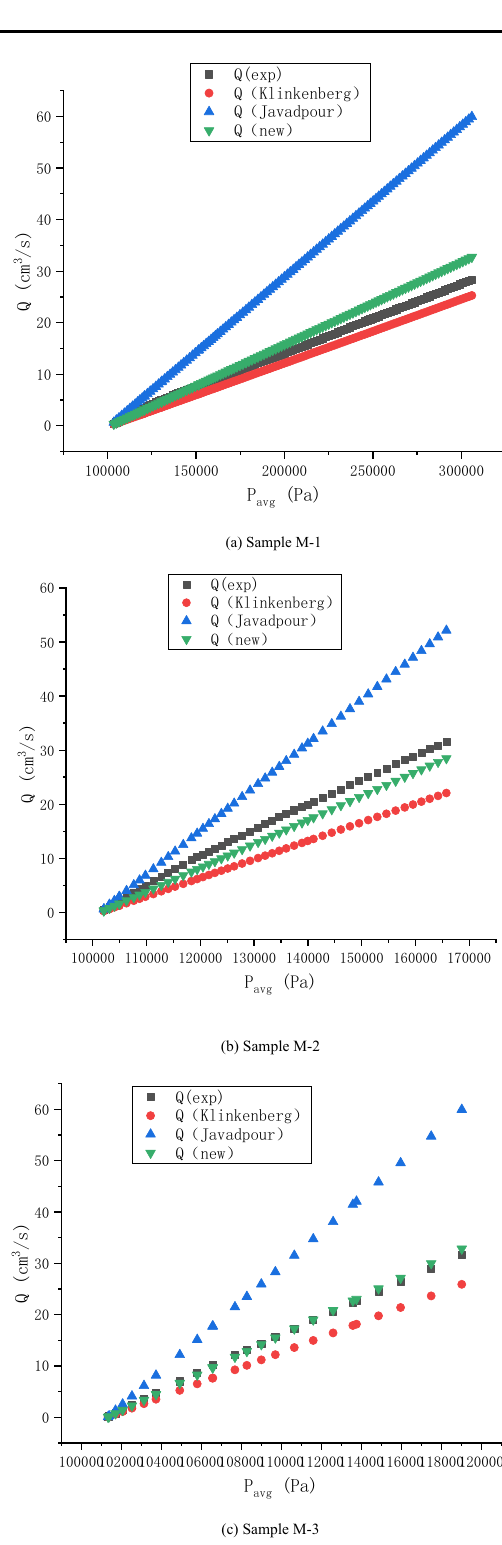
Fig. 6 Comparison of model data and experimental